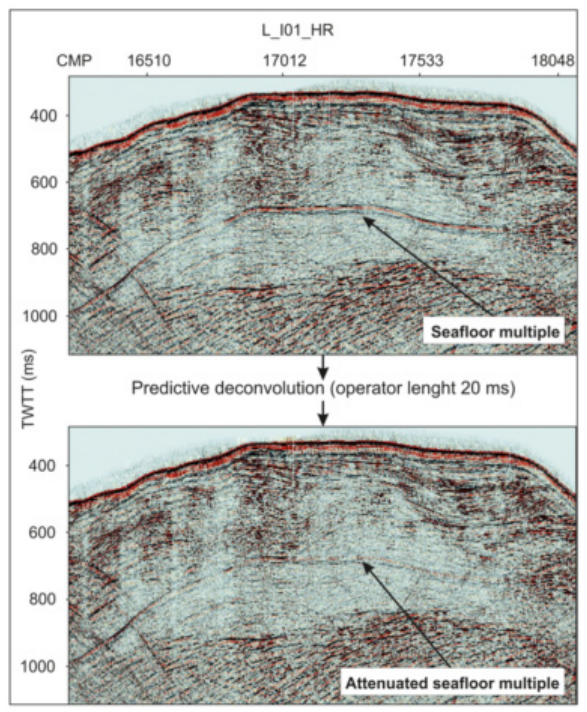
Figure 14. Effects of predictive deconvolution on a portion of a stacked section of the L_I01_HR line (Ionian Sea, see Figure 3 for line location), using an operator length of 20 ms. Note the good at- tenuation of the sea-floor